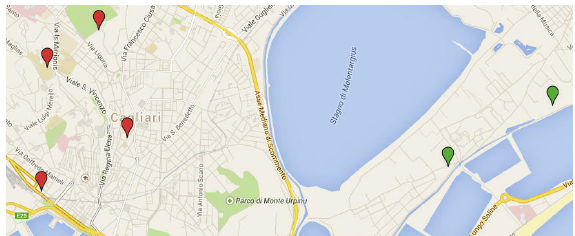
Figure 1: Measurement spots in Cagliari for urban (red marks) and suburban (green marks)